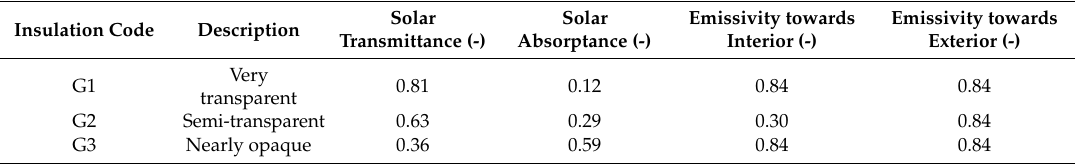
Table 2. Thermo-physical properties for the analyzed single glazing.